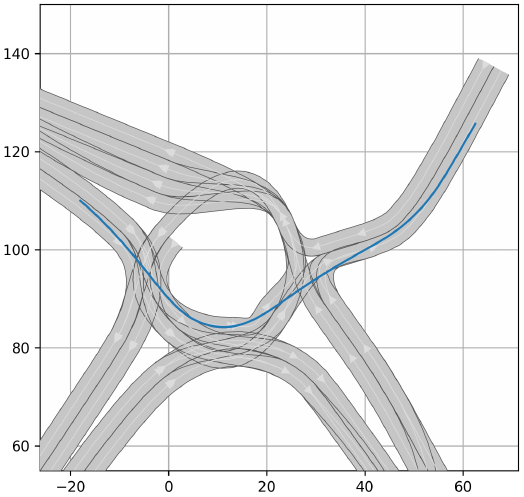
Figure 7. Boston seaport region with a trajectory from nuScenes data in the simulated scenario (coordinates: 42 ◦ 20’51 (cid:48)(cid:48) N, 71 ◦ 02’09 (cid:48)(cid:48) W, eye altitude 179 m).